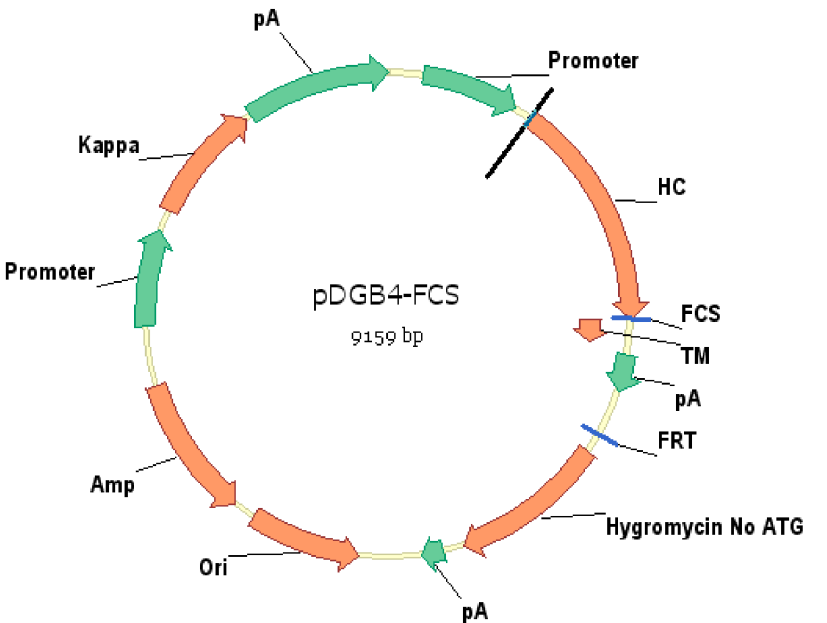
Figure 1. Schematic illustration of vector pDGB4-FCS. The vector contains both heavy chain and light chain expression cassettes. After integration of the vector into the genome of host cell, the full-length antibody can be expressed as both displayed and secreted versions simultaneously on cell surface as well as in condition medium.